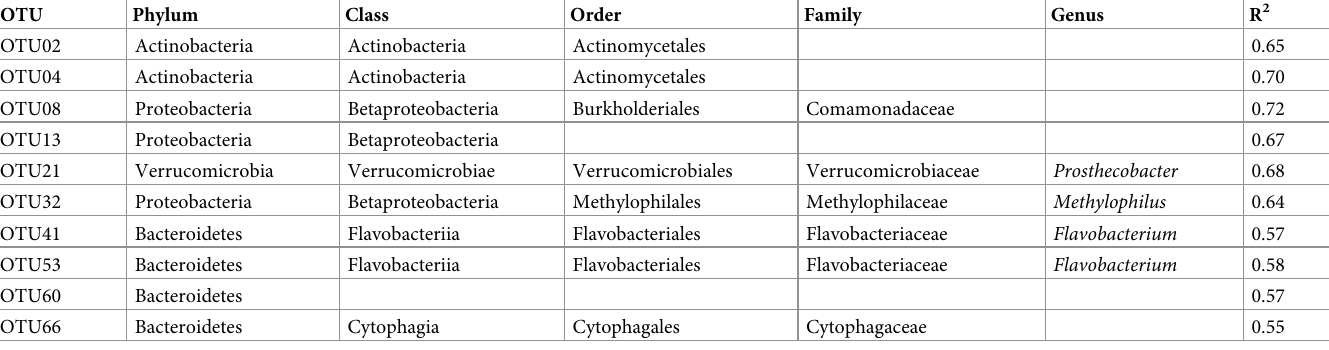
Table 3. OTUs that correlated (Envfit analysis, R 2 ) with bacterioplankton assemblages plotted in NMDS space. OTU